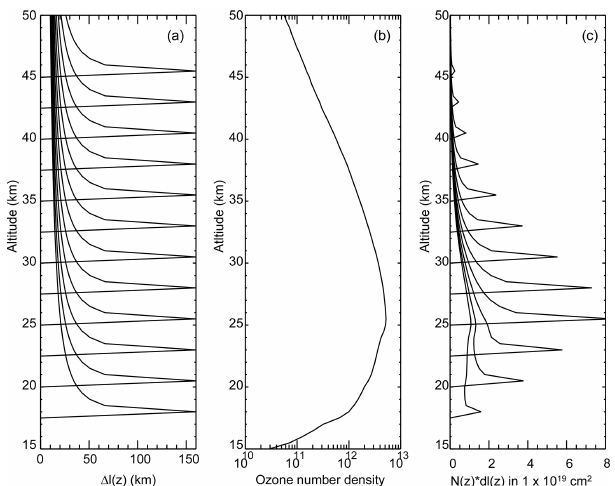
Figure 4. (a) Profiles of (cid:49)l i,j (in km) for tangent altitudes from 18 to 45.5km in 2.5km steps in tangent altitude, (b) a representative ozone profile n O ( z ) in cm − 3 , and (c) the product of the curves in 3 (a) with the ozone profile shown in (b) so that (cid:49)l i,j × n O 1 × 10 19 cm − 2 . The profiles were taken from the November 1984 v7.00 data set, event no.